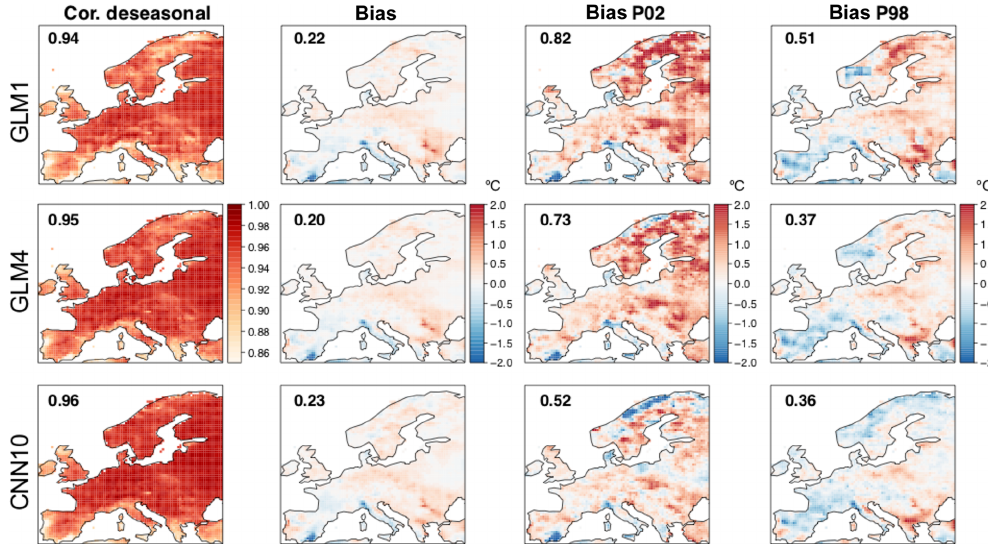
Figure 5. Maps showing the spatial results obtained in terms of the different metrics considered for temperature (in columns) for the two benchmarking versions of GLM (top and middle row) and the best-performing method, the CNN10 (bottom row). The numbers within the panels show the spatial mean absolute values (to avoid error compensation).